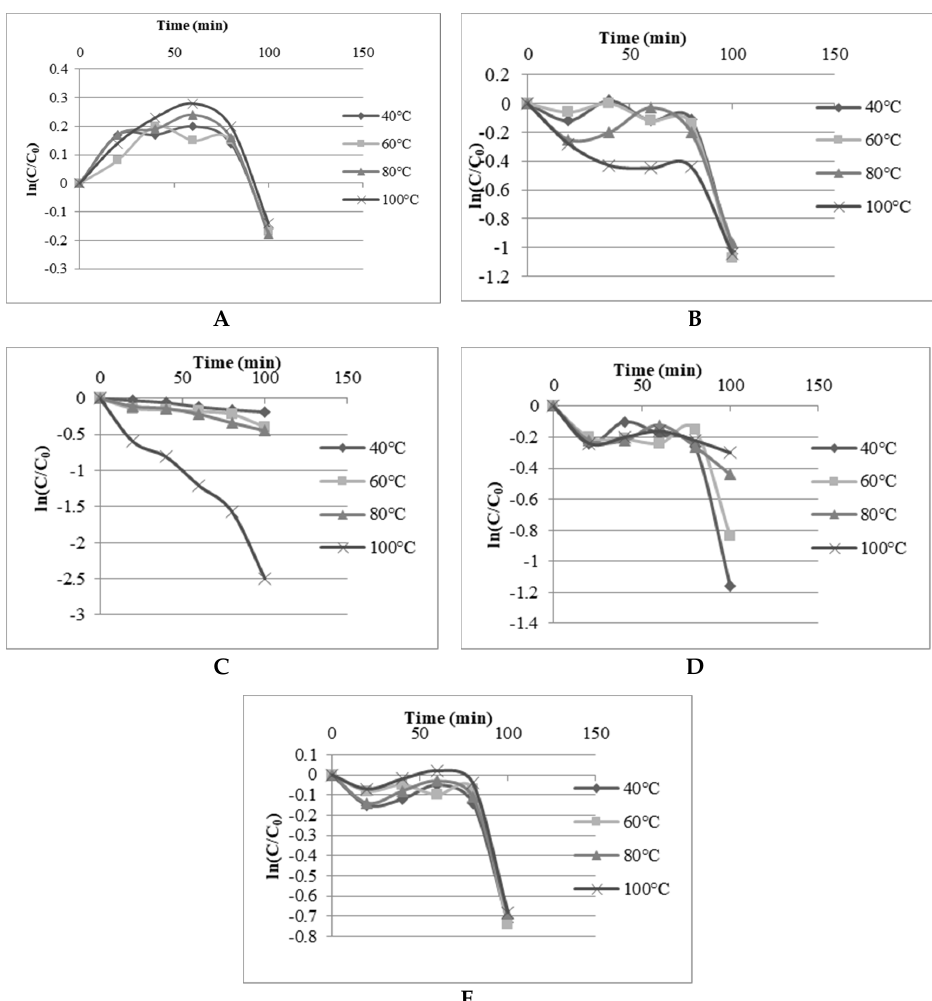
Figure 4. Stability of TPC ( A ), TFC ( B ), TACN ( C ), DPPH radical scavenging ( D ) and FRAP ( E ) values in SAFA.